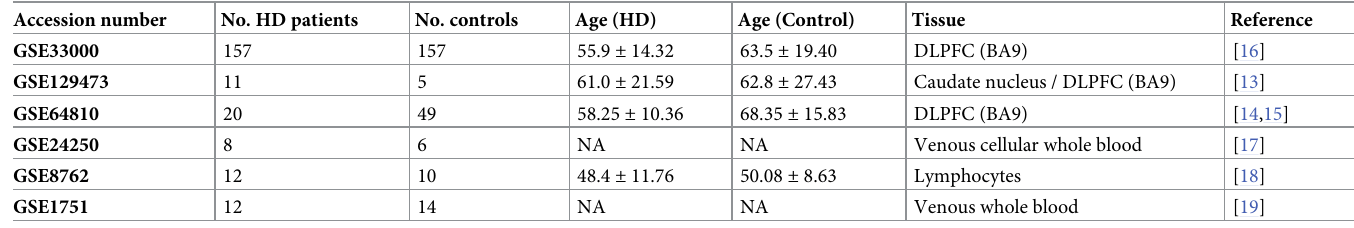
Table 1. Information on patients from the analysed transcriptomic